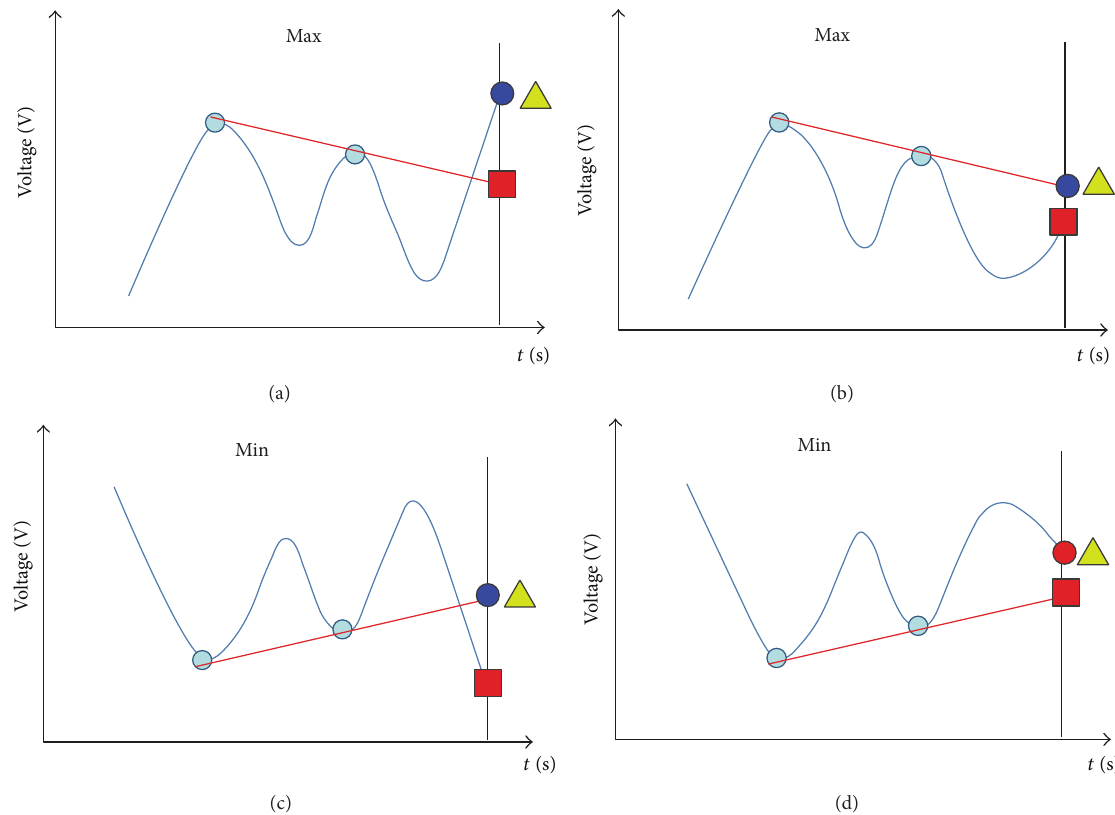
Figure 5: The boundary prediction method. ◼ —endpoint; e —1 order approximate point: the intersection of the vertical axis and the curve, that is, straight line continuation of two extreme value points near the end; 󳵳 —the last extreme value that is obtained through the boundary prediction method; the formula of extreme value is as follows through boundary prediction method: The Extreme Point = MAX {| endpoints |,| 1 order approximate point |} .